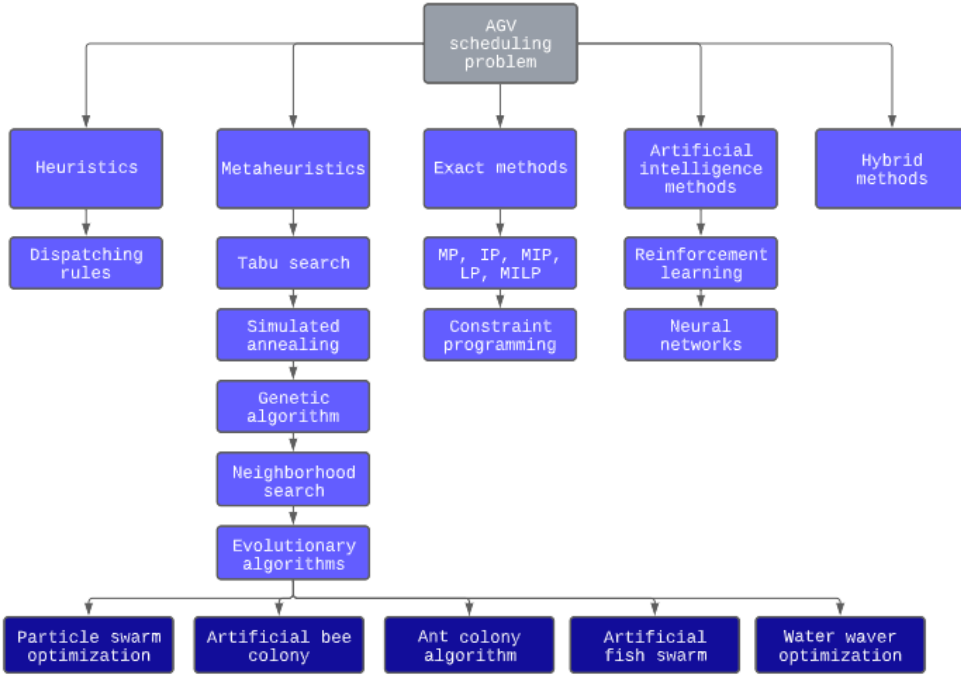
Figure 1. Algorithms for AGV scheduling problems identified in the literature.